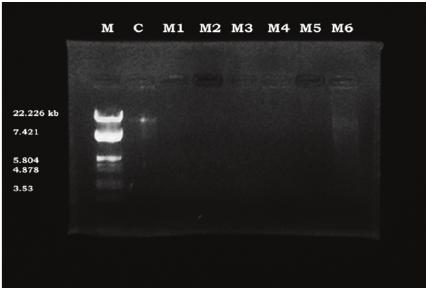
Figure 5: Gel picture showing the cleavage analysis of samples.